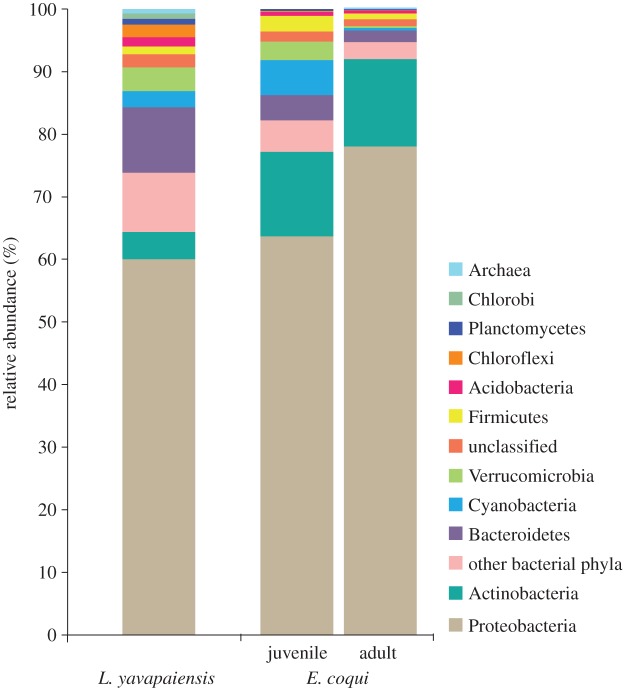
Relative abundance of 16S V4 amplicons by major phyla after rarefaction at 5000 reads per individual.